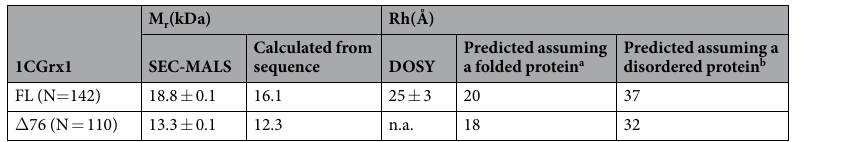
Table 1. Experimental and calculated molecular mass (M r ) and hydrodynamic radius (Rh) for FL- and Δ 76- 1CGrx1. a Calculated using the following equation from ref. 34 : = . ± . . ± . R N (4 75 1 11) hfold 0 29 0 02 . b Calculated using the following equation from ref. 34 : = . ± . . ± . R N (2 21 1 07) hdiso 0 57 0 02